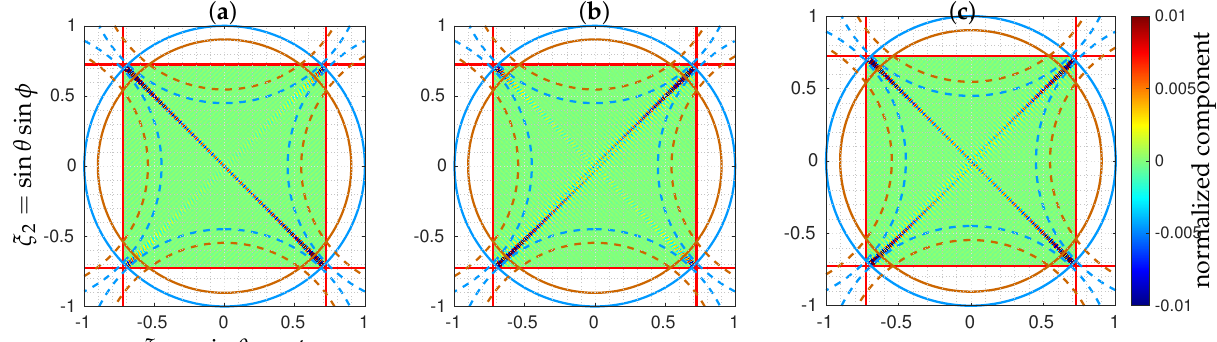
Figure 14. Singular vectors V (cid:96) of (cid:101) G corresponding to the smallest singular values σ (cid:96) when the shortest spacing of the cross-shaped array shown in Figure 4 is set to d = 0.69 λ . Only the last three singular vectors are shown here for ( a ) (cid:96) = N f − 2 = 13,859 with σ 13859 (cid:39) 8.1 · 10 − 6 , ( b ) (cid:96) = N f − 1 = 13,860 with σ 13860 (cid:39) 7.8 · 10 − 6 , and ( c ) (cid:96) = N f = 13,861 with σ 13861 (cid:39) 1.6 · 10 − 6 . Components of V